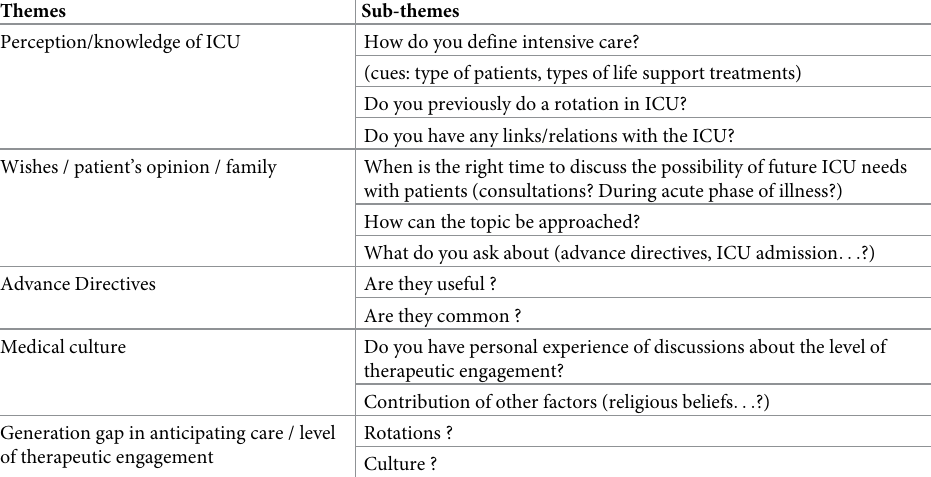
Table 1. English translation of the interview